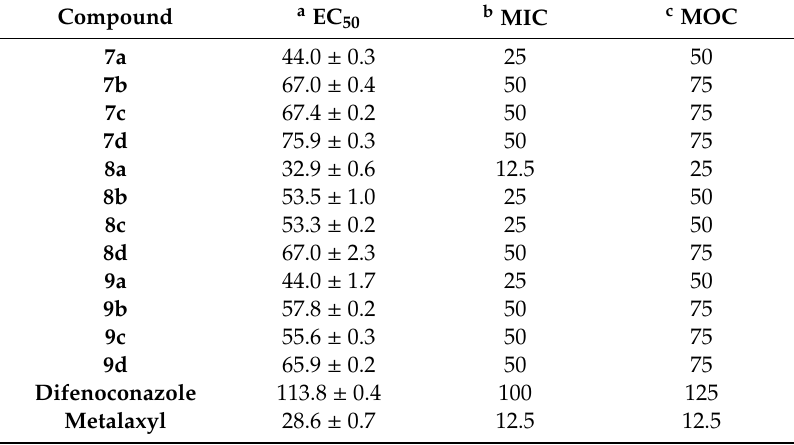
Table 1. Inhibition of mycelial growth by 2 (cid:48) -hydroxy-chalcone derivatives against P. infestans.